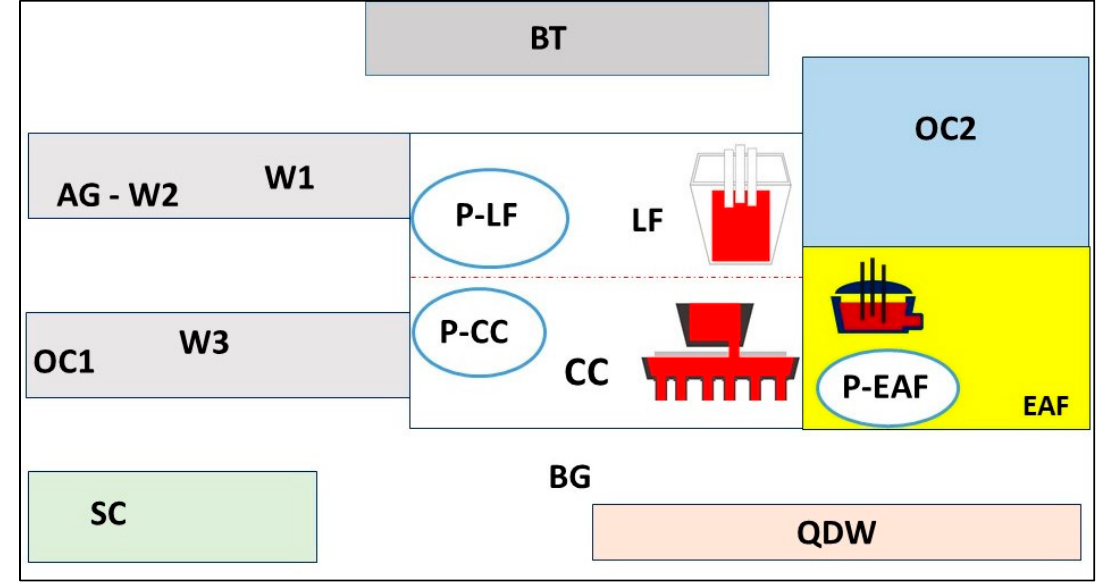
Figure 1. Sampling sites inside and outside the factory.